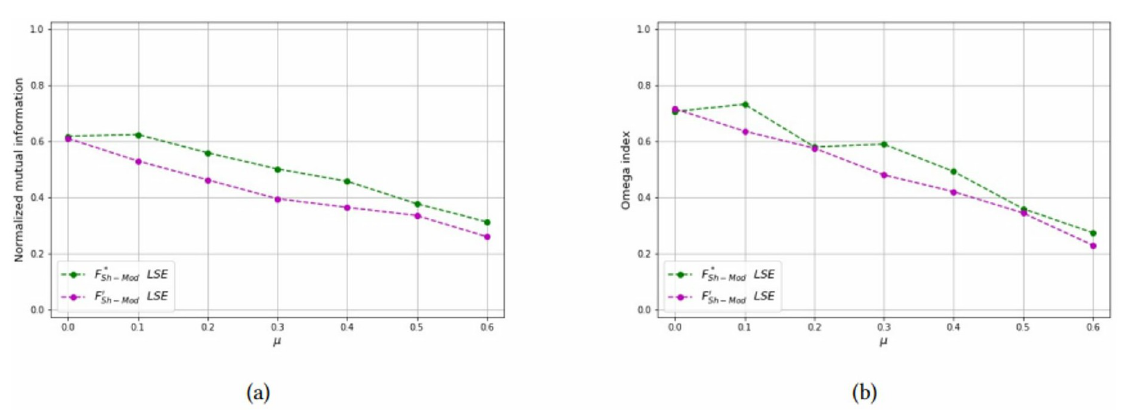
Fig 22. Test results on overlapping communities, parameters N = 500, n c = 25, p = 3, μ o = 0.7, N o = 20. (a) Average NMI for each solution method, (b) Average Omega for each solution method.